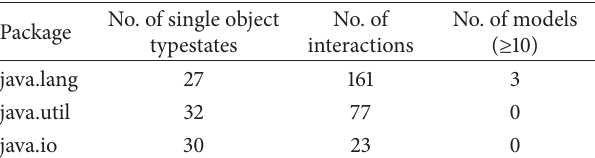
Table 4: Results of mined typestates. The third column is the total number of interactions for the package, and the last column is the